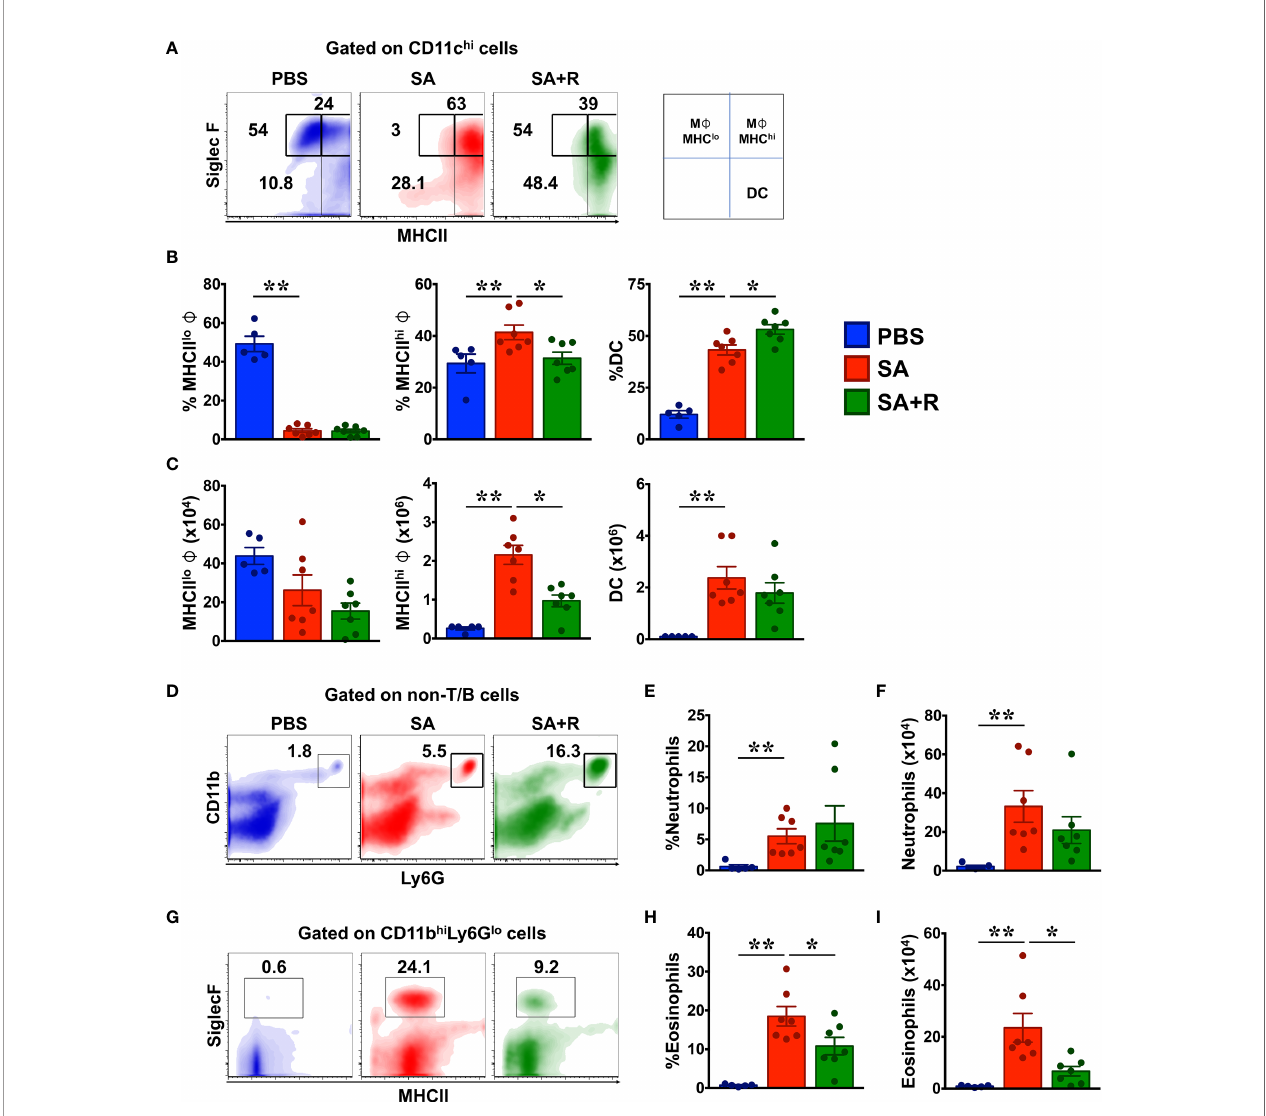
FIGURE 4 | Ruxolitinib reduces M1 macrophages and eosinophils but not neutrophils in the lungs of SA mice. (A – I) Lung cells were analyzed for various innate immune cell populations by fl ow cytometry. Representative density plots (A, D, G) , average frequency (B, E, H) and total cell numbers (C, F, I) of macrophages, dendritic cells (DC), neutrophils and eosinophils from PBS, SA and SA+R mice are shown. Data is pooled from 2 independent experiments and presented as mean ±; SEM of at least 5-7 mice per group. Statistical signi fi cance was determined using Student ’ s unpaired t test with Welch ’ s correction.*p < 0.05, **p <